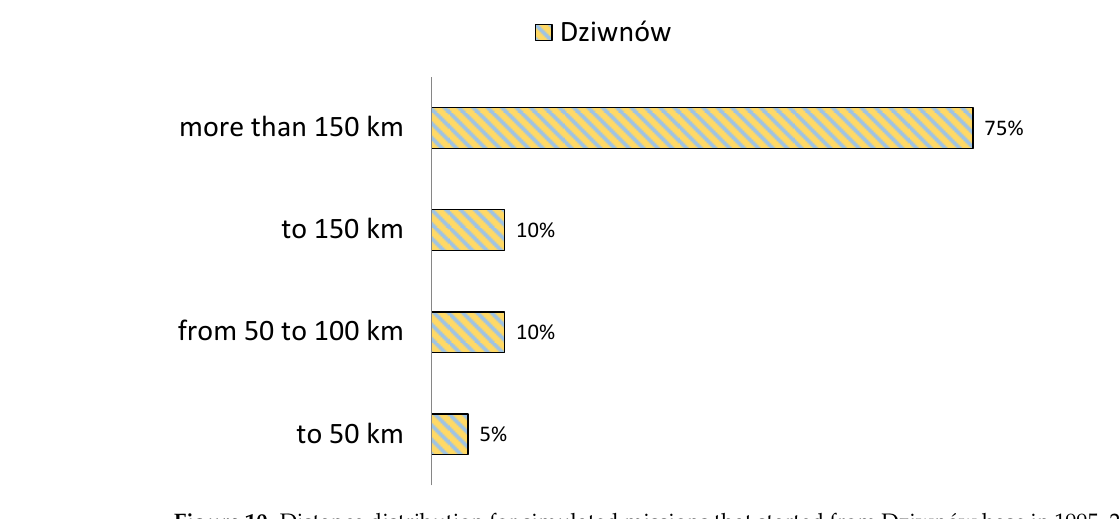
Figure 10. Distance distribution for simulated missions that started from Dziwnów base in 1995–2001; W3-RM and Mi-13PS helicopters were used.